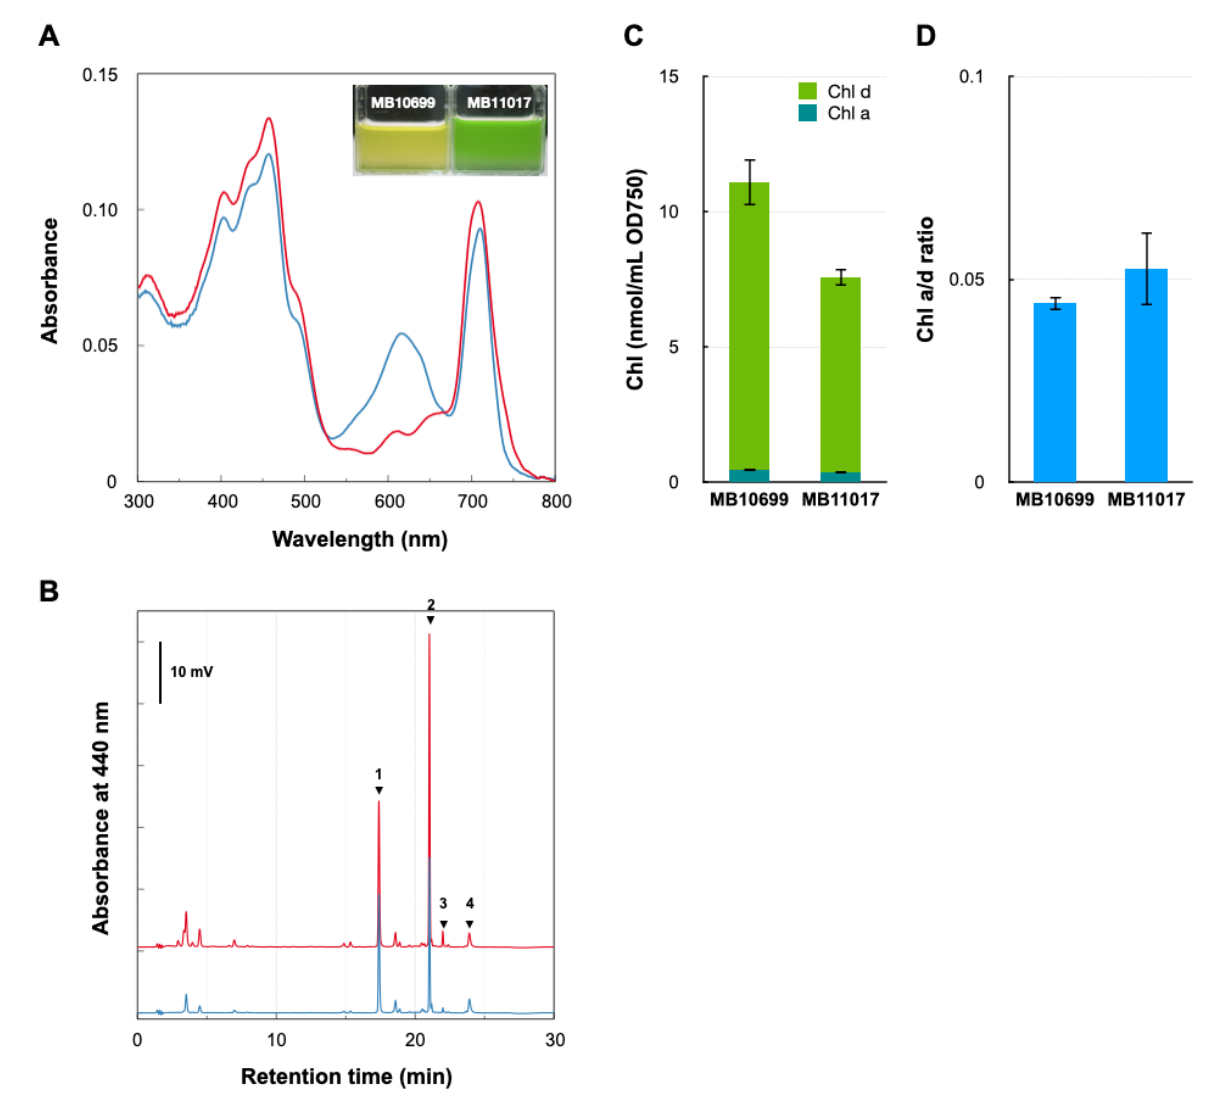
Figure 1. Comparison of cellular pigments between two Acaryochloris strains. ( A ) In vivo cellular spectra of A . marina MBIC10699 (red) and A. marina MBIC11017 (blue). Inset: picture of each culture. ( B ) HPLC profile of total pigments extracted with methanol from cells of A . marina MBIC10699 (red) and A. marina MBIC11017 (blue) monitored by absorption at 440 nm. Each arrow indicates zeaxanthin (1), Chl d (2), Chl a (3), and α -carotene (4), respectively. ( C ) The amounts of Chl a (dark green) and Chl d (green) were measured in two Acaryochloris strains. ( D ) The ratio of cellular Chl a/d amounts in the two Acaryochloris strains.